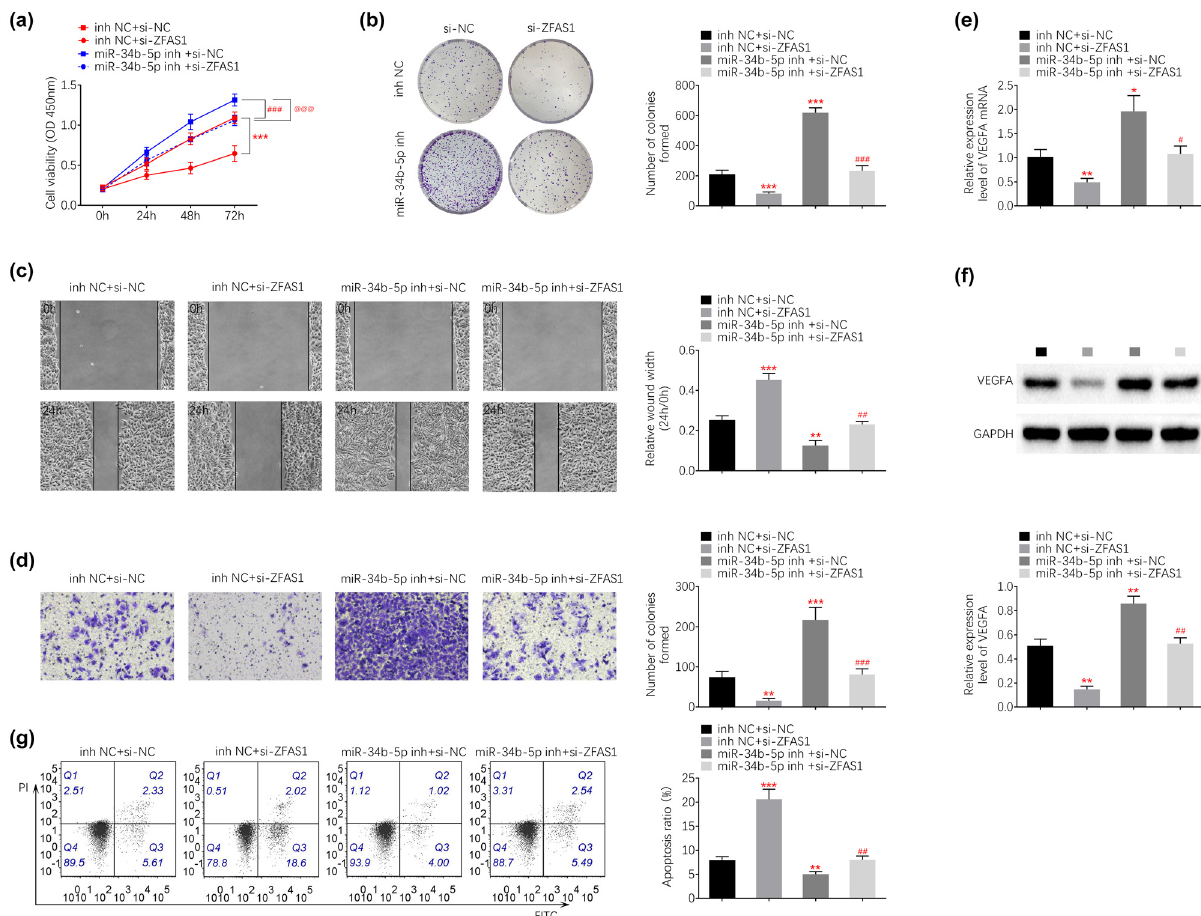
Figure 5: Silence of ZFAS1 suppressed endometrial carcinoma cell growth and metastasis through increase in miR - 34b. ( a ) Transfection with miR - 34b inhibitor increased cell viability of HEC - 1B, and attenuated ZFAS1 silence - induced decrease in cell viability. ( b ) Transfection